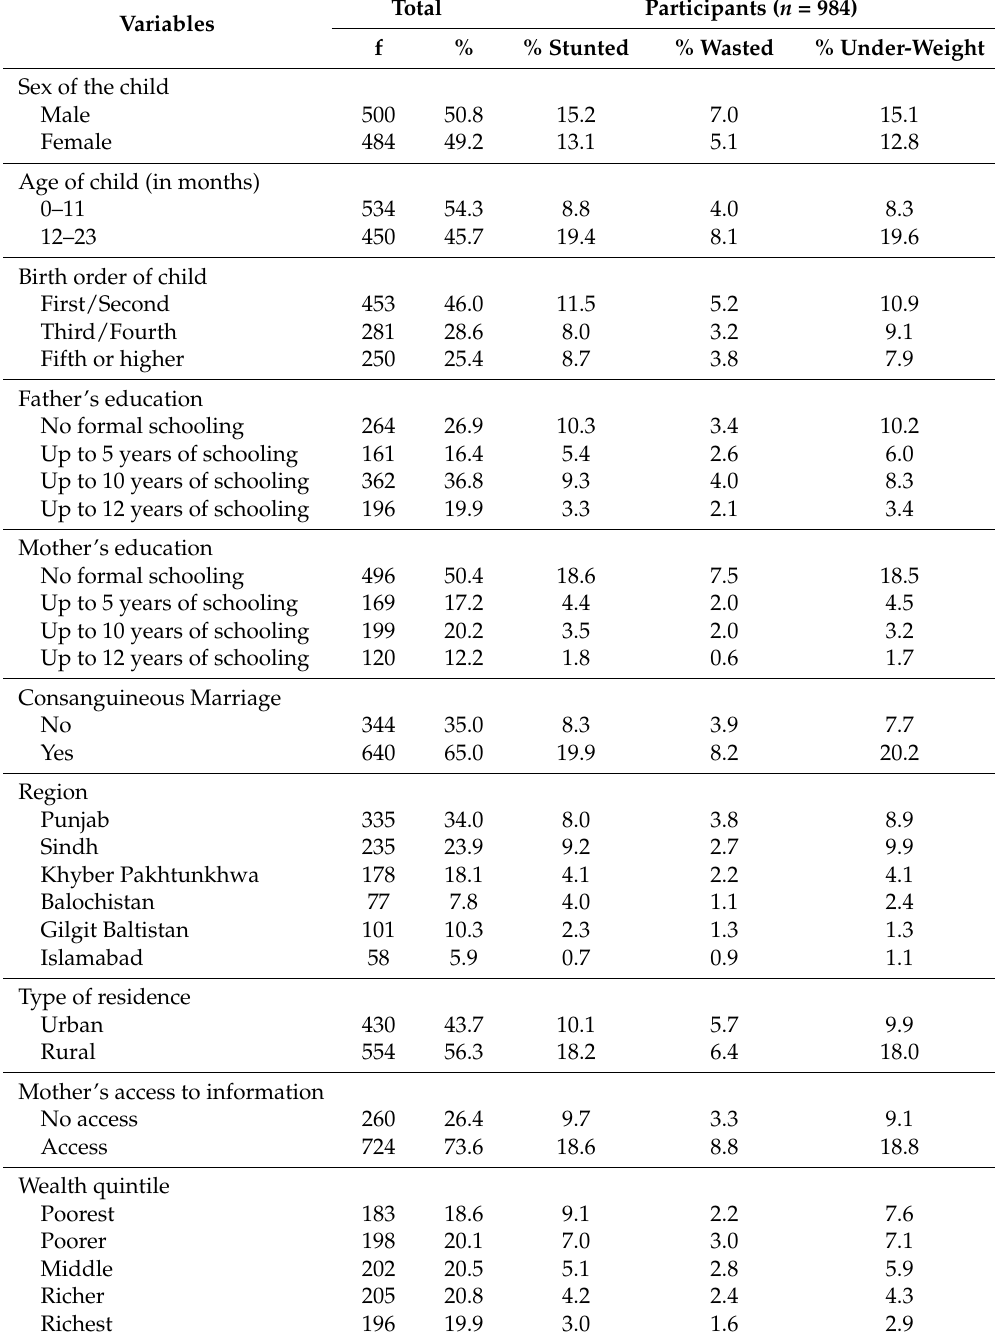
Table 1. Socio-demographic characteristics of children under two years of